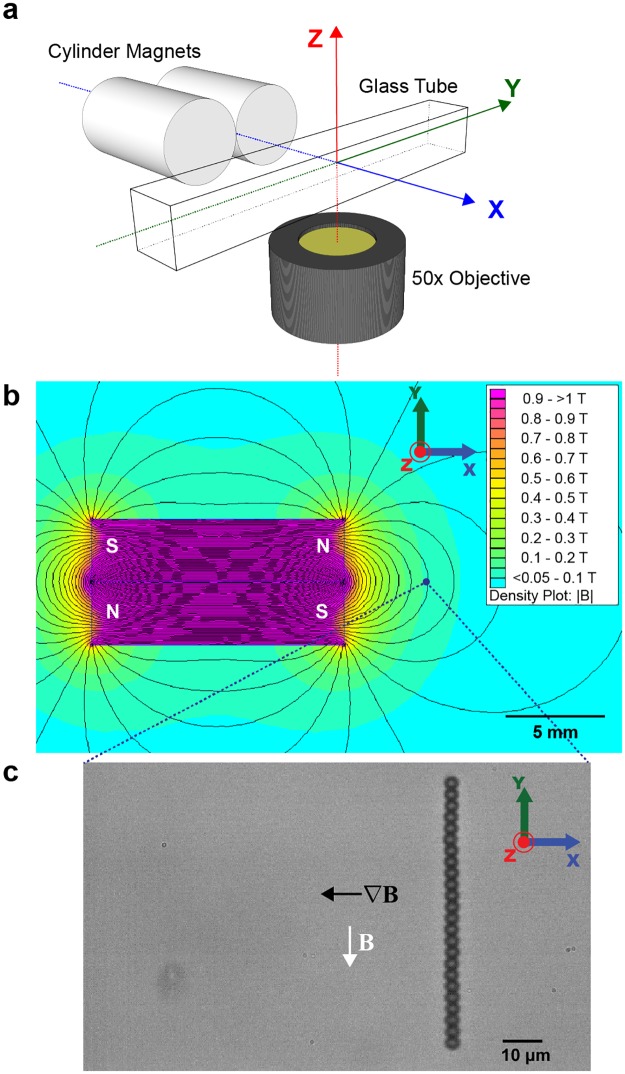
Magnetic tweezers setup for perpendicular translation of bead chains.(a): Schematic representation of the magnetic tweezers with a pair of cylinder magnets. The cylindrical magnets are magnetized in the axial direction, and they are paired up in an anti-parallel fashion. (b): Finite element simulation of the cylinder magnets pair using Finite Element Method Magnetics (FEMM 4.2). Cross section of the x, y-plane through the geometric center along z-axis is shown. Field density |B| decreases from pink to blue. N and S denote north and south poles respectively. Black lines represent computed magnetic field lines. Blue dot is a schematic field of view of the 50X objective, and blue dotted lines show zoom direction. Scale bar, 5 mm. (c): As viewed in the field of view, a 24-bead chain in the magnetic field of a pair of magnets, aligning with the field B (white arrow) along the y-axis, and translating towards the magnetic field gradient ∇B (black arrow). Scale bar, 10 μm.